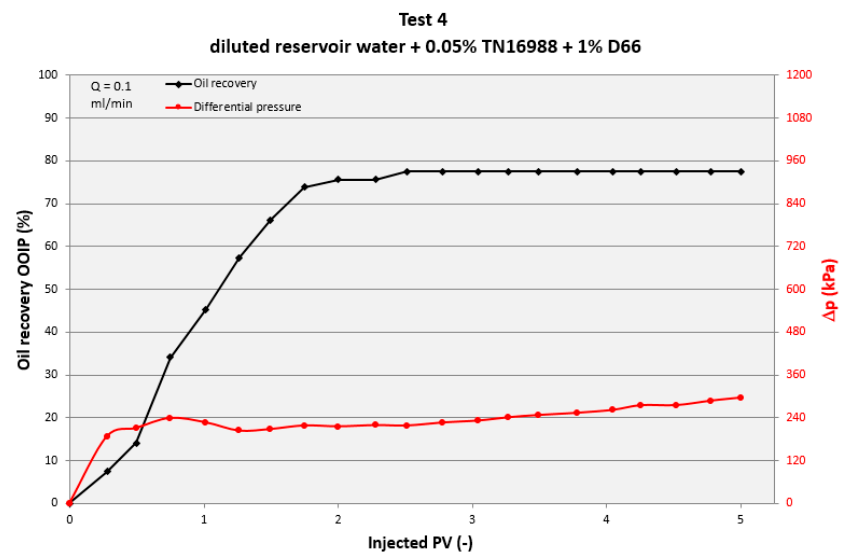
Figure 7. Recovery factor for diluted reservoir water with the addition of 0.05% polymer and 1% nanoemulsion.